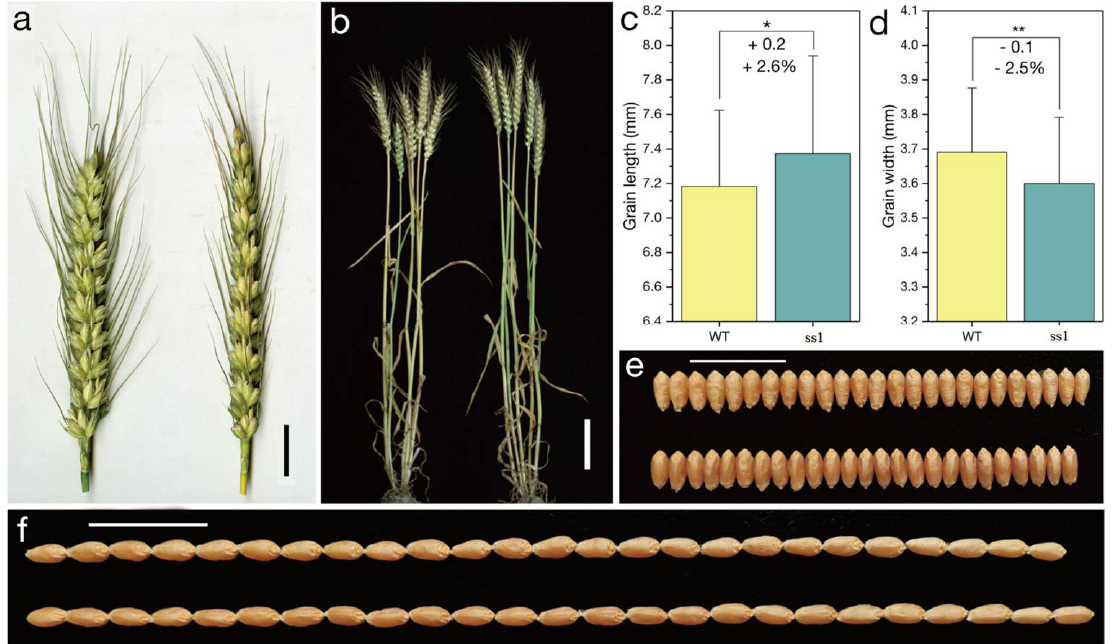
Figure 2. Phenotype of the mutant ss1 . ( a ) Spikes of the wild-type (WT) ( left ) and ss1 ( right ) plants. Scale bar, 2 cm. ( b ) WT ( left ) and ss1 ( right ) plants. Scale bar, 10 cm. Comparisons of grain length ( c ) and grain width ( d ). **, p < 0.01; *, p < 0.05. Data are presented as the mean ± standard deviation. ‘+’ and ‘−’ indicate more and less than the WT control, respectively. ‘+0.2′ in panel ( c ) indicates the ss1 grain was 0.2 mm longer than the WT grain (on average). ‘+ 2.6%’ in panel ( c ) indicates Q s1 increased the grain length by 2.6% (on average). ( e ) Kernel width of the WT ( upper ) and ss1 ( lower ) samples. Scale bar, 2 cm. ( f ) Kernel length of the WT ( upper ) and ss1 ( lower ) samples. Scale bar, 2